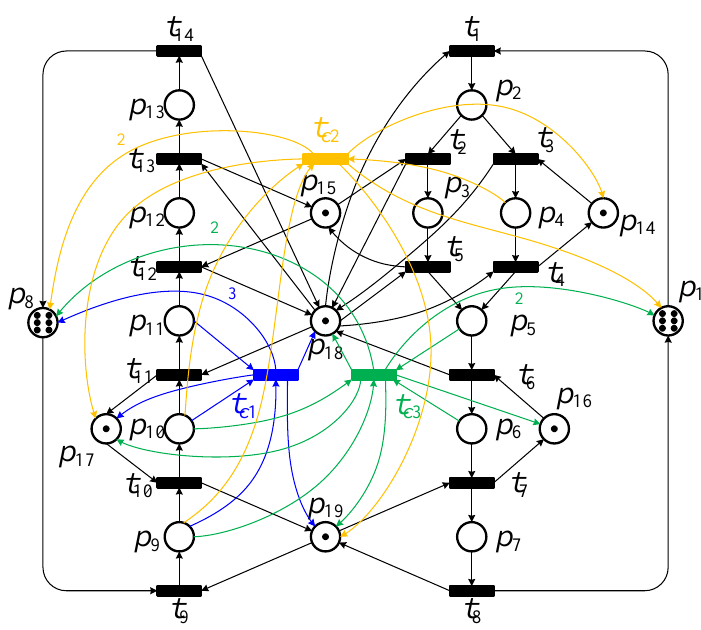
Figure 7. Controlled system of Figure 6. Figure 7. controlled system of Figure 6.